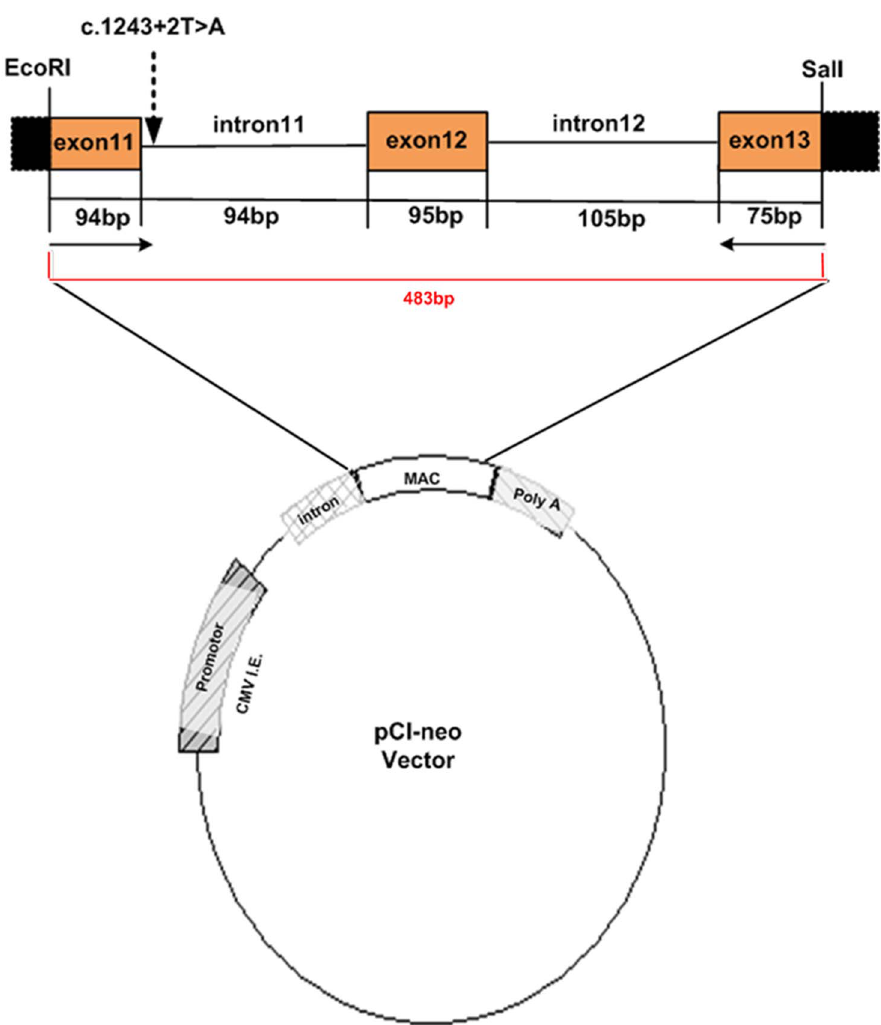
Figure 5. Structure of RPE65 minigene. The pCIneo minigenes of RPE65 gene were constructed to contain three exons (exon 11, 12, and 13) and flanking intronic sequences (intron 11 and 12) from wild or mutant type (c.1243 + 2T . A) of RPE65 gene. Eco RI and Sal I represent restriction enzyme sites. Horizontal arrows indicate the positions and the directions of the primers. The red 483 bp indicates the amplified product.